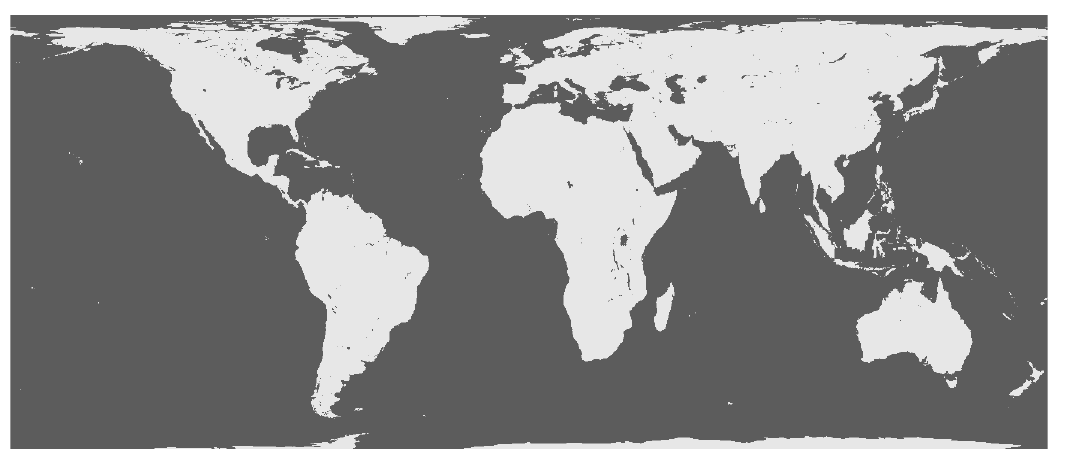
Figure 2. Cylindrical EASE-Grid